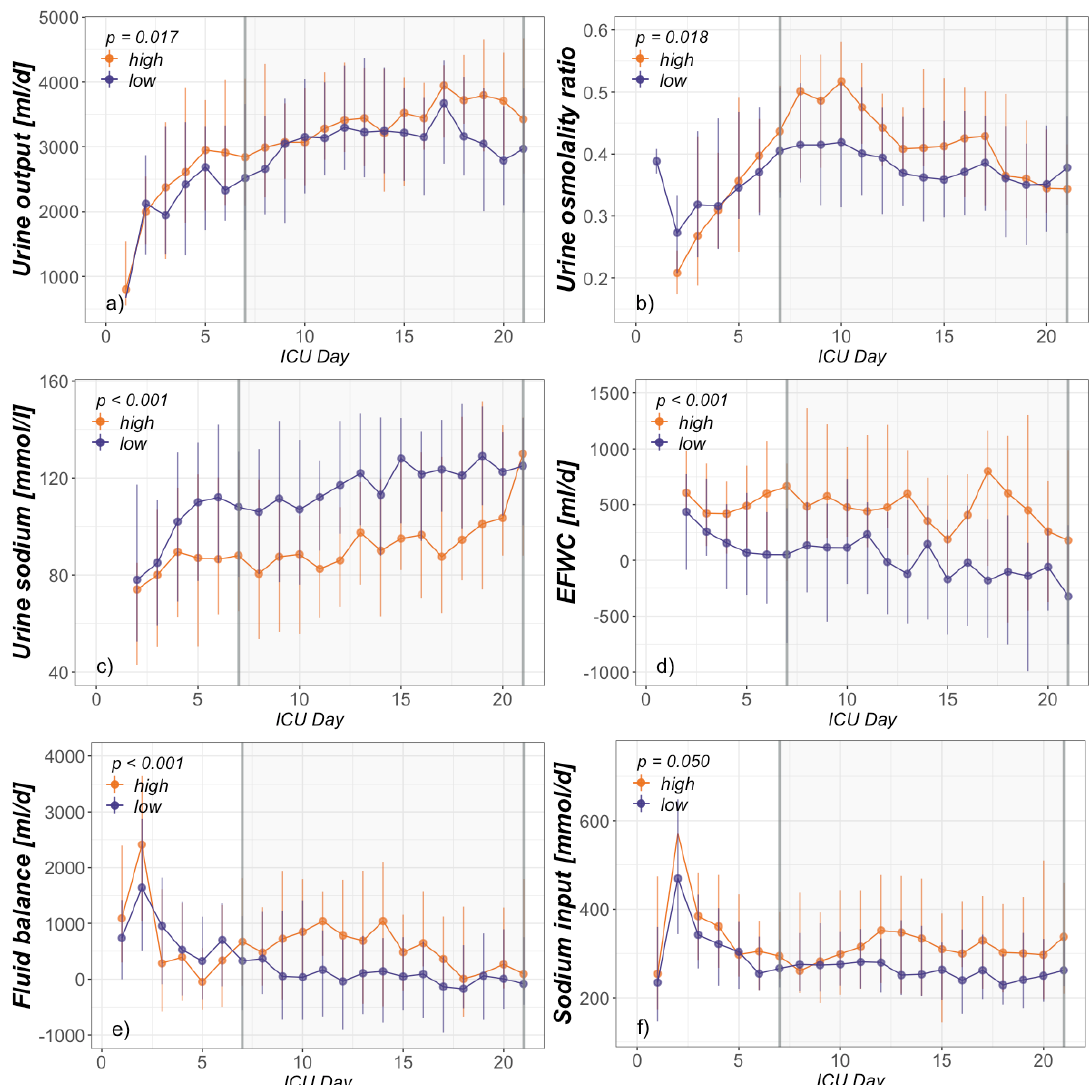
Figure 2. Electrolyte-free water clearance, fluid balance and sodium intake. ICU day-dependent group analysis presented as daily median and interquartile range from admission to day 21 of ( a ) urine output, ( b ) urine osmolality ratio (urea / not urea), ( c ) urine sodium output, ( d ) electrolyte-free water clearance (EFWC), ( e ) fluid balance and ( f ) sodium intake. The range of statistical interest (ICU day 7–21) is indicated by the gray-shaded area.